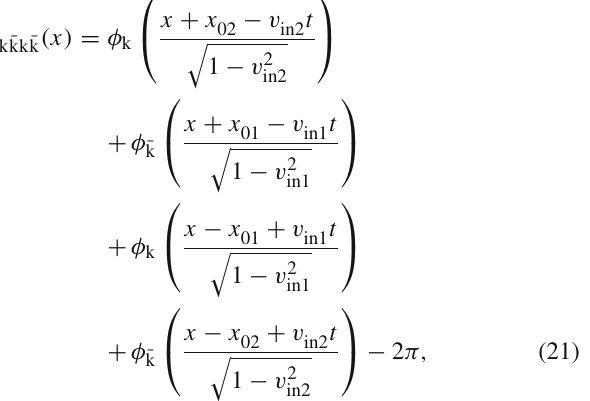
simultaneous collision of all four waves in the origin x =